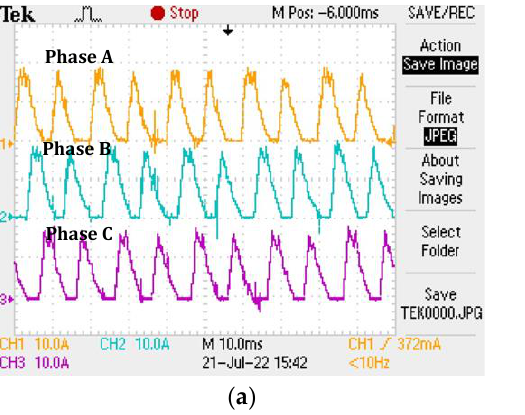
Figure 21. The proposed SRM experiment results of the phase current waveforms at 1500 rpm with load: ( a ) phase A, B and C current; ( b ) phase D, E and F current.